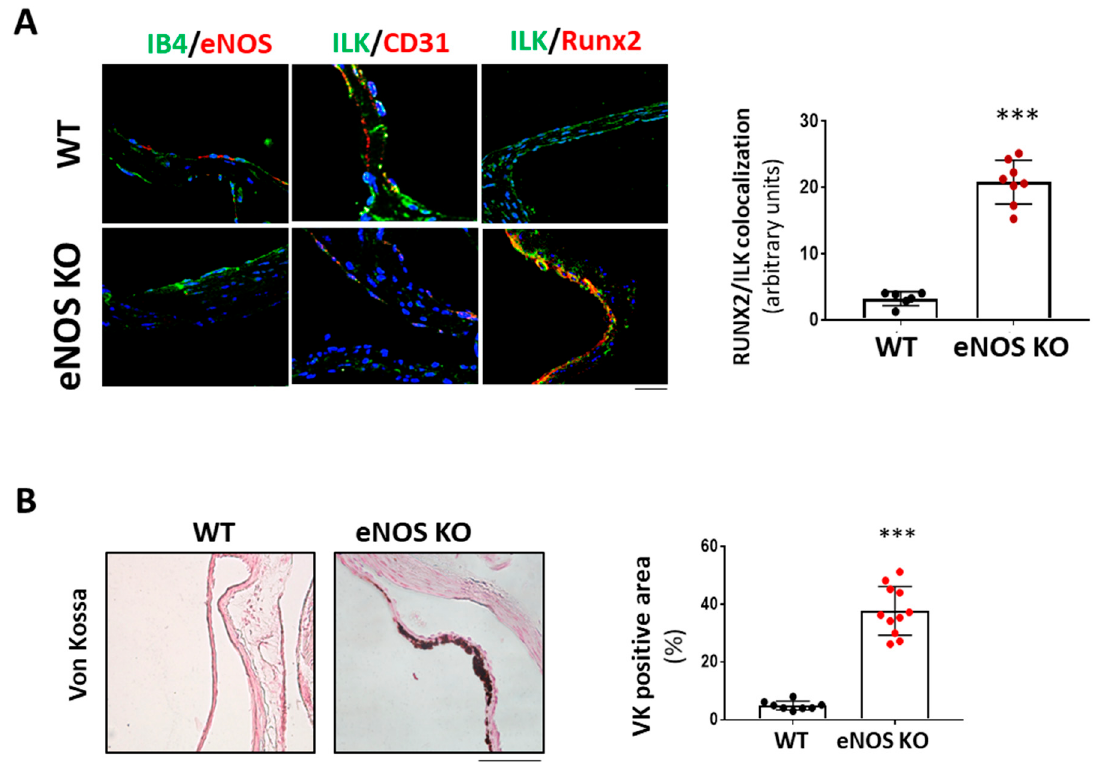
Figure 6. eNOS knock-out mice exhibited valve calcification, which correlates with low levels of ILK expression and increased RunX2 in valve endothelium. ( A ) Confocal microscopy image of endothelial marker IB4 in green and eNOS in red (left panel); ILK in green and endothelial marker CD31 in red (central panel); and ILK in green and Runx2 in red (right panel) in eNOS KO mice vs. WT. On the left, quantitation of ILK/RUNX2 colocalization in valve endothelium. N = 8. *** p < 0.0001 vs. WT. ( B ) Von Kossa staining in aortic valves of WT and eNOS KO mice. Scale bar = 50 µ m. A quantification of VK positive area with respect to total area is shown below. n = 11. *** p < 0.0001 vs. WT.